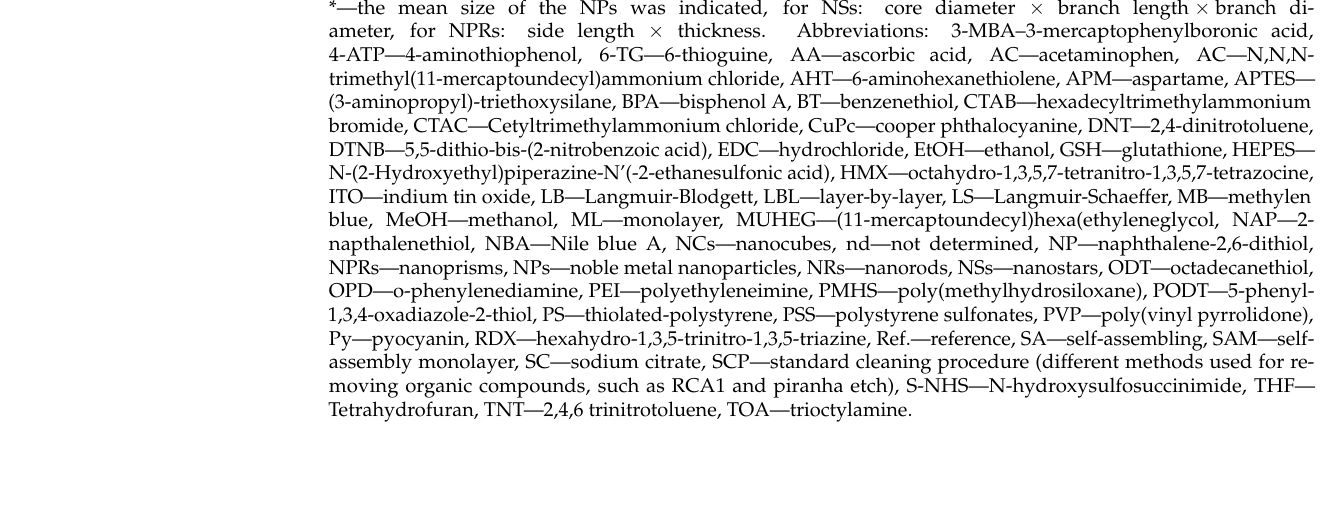
*—the mean size of the NPs was indicated, for NSs: core diameter × branch length × branch di- ameter, for NPRs: side length ×